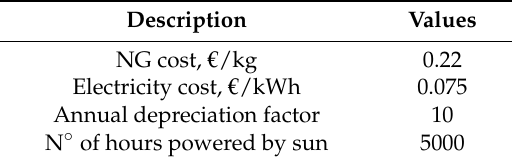
Table 3. Key economic parameters for the economic evaluation.